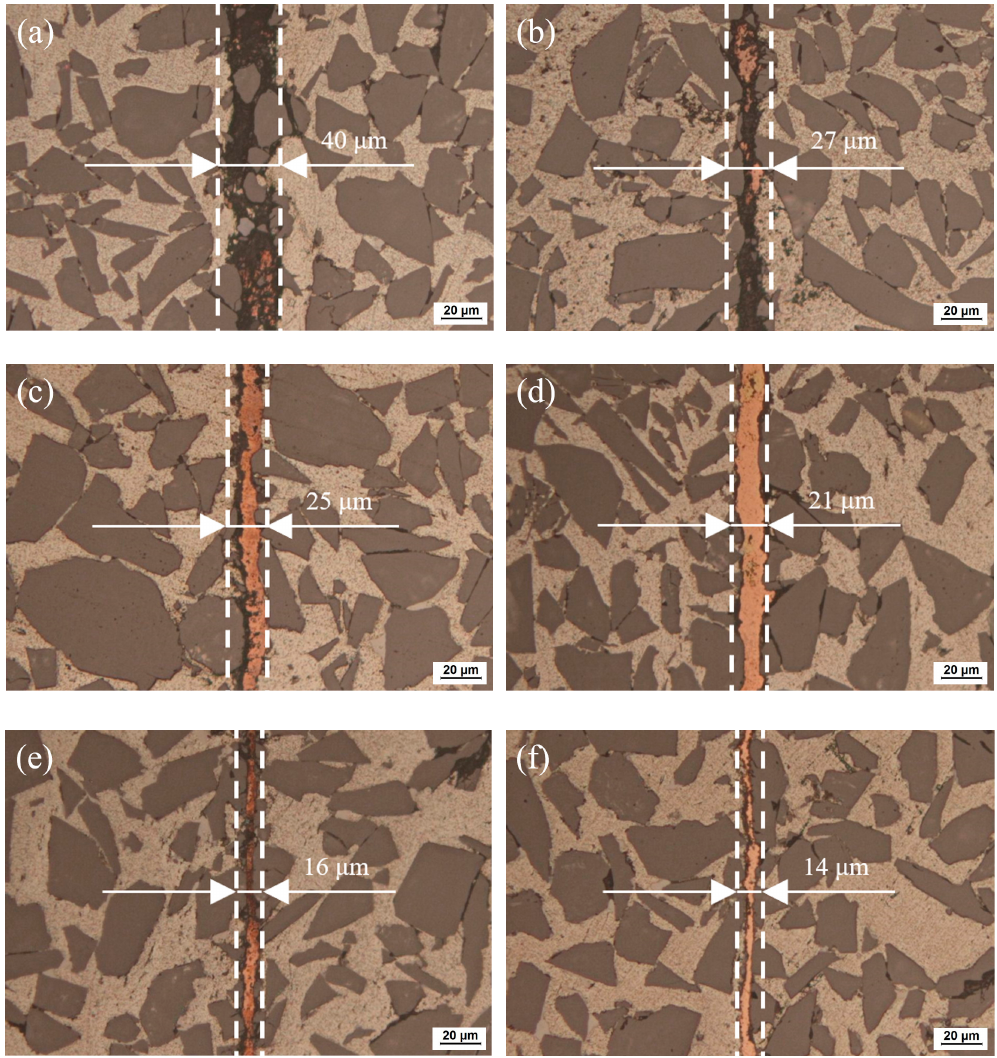
Figure 4. Optical micrographs of 65 vol.% SiC p /6063 Al MMC joint diffusion using liquid gallium with nano-copper particles at different temperatures: ( a ) 400 °C; ( b ) 420 °C; ( c ) 440 °C; ( d ) 450 °C; ( e ) 460 °C; ( f ) 480 °C.